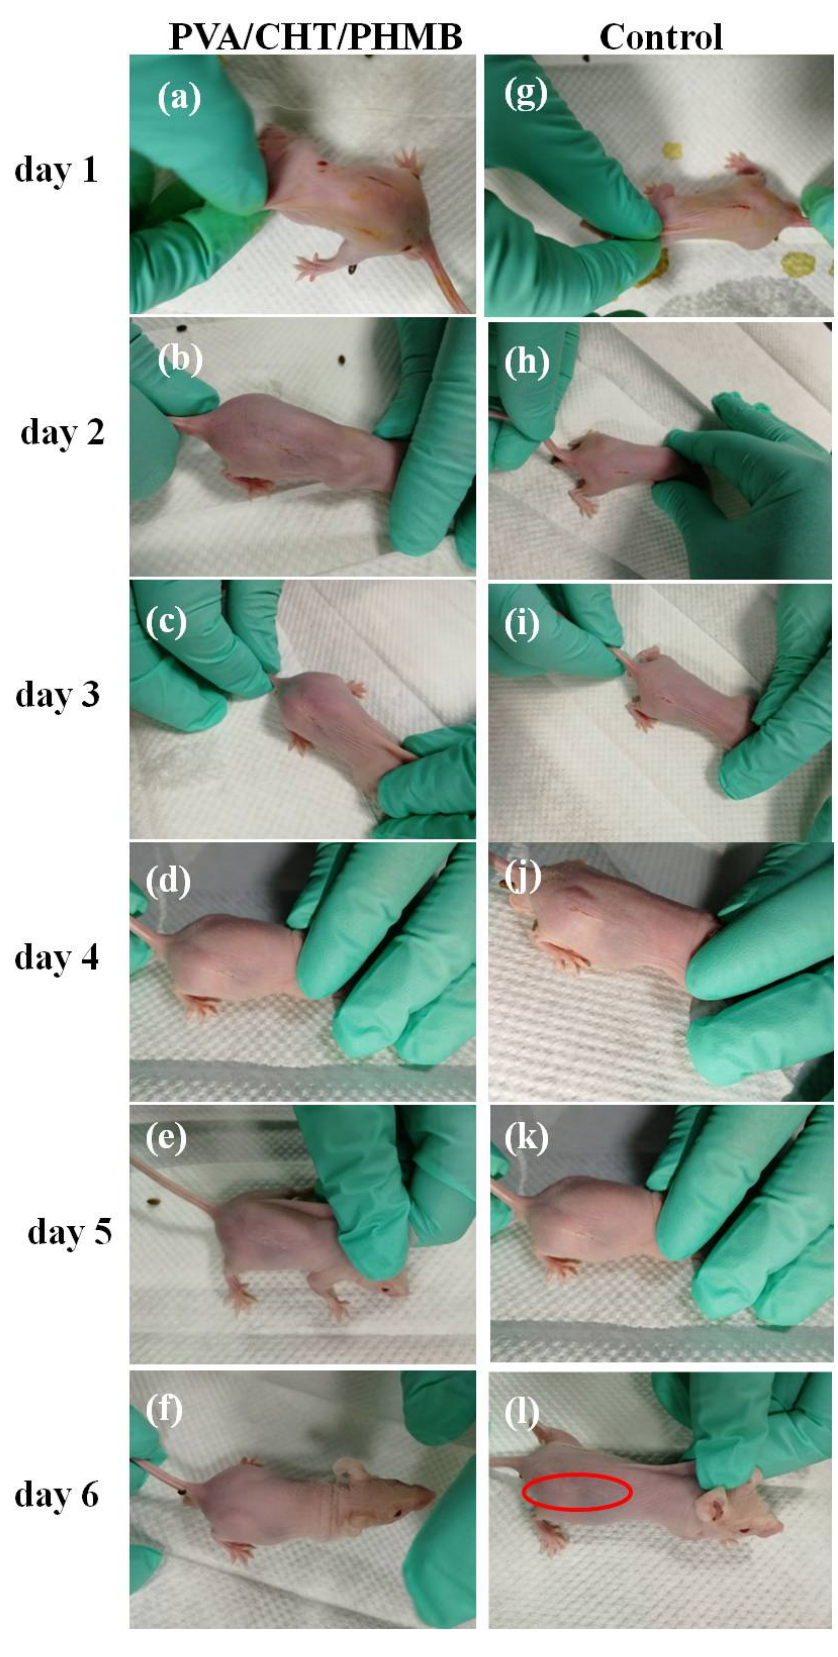
Figure 6. Scratch wound healing test in nude mouse. Compared with the control group (Figure 6 g – l )